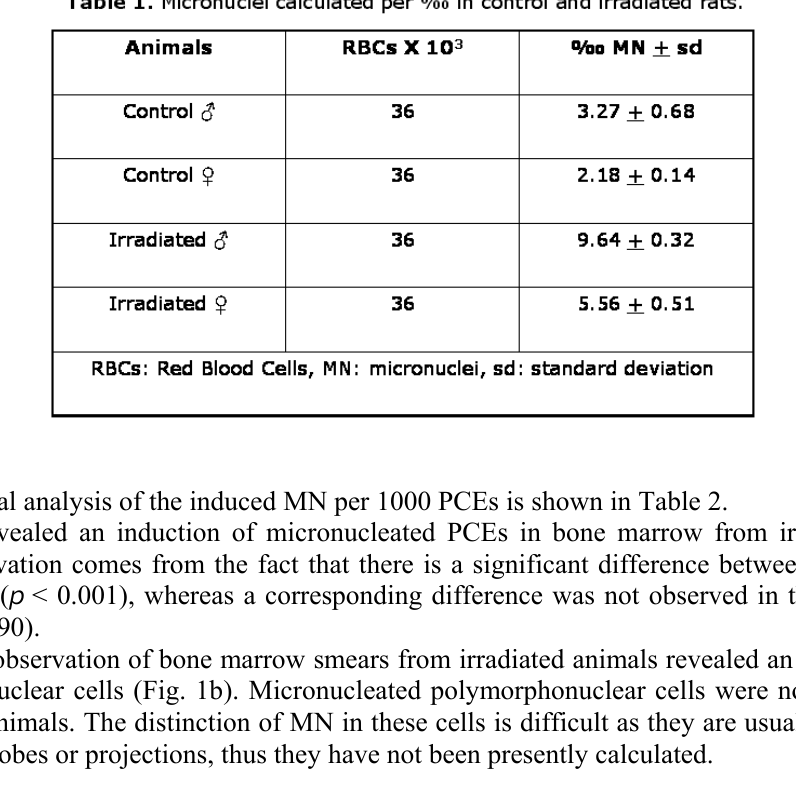
shows micronucleated PCEs from irradiated rats (a) and